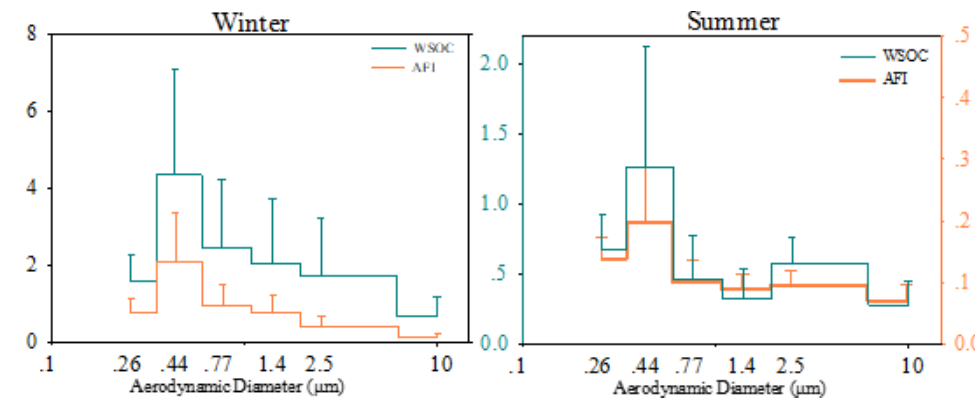
Figure 3. Size distributions of WSOCs and the AFI in winter and summer. The AFI is in Raman units.